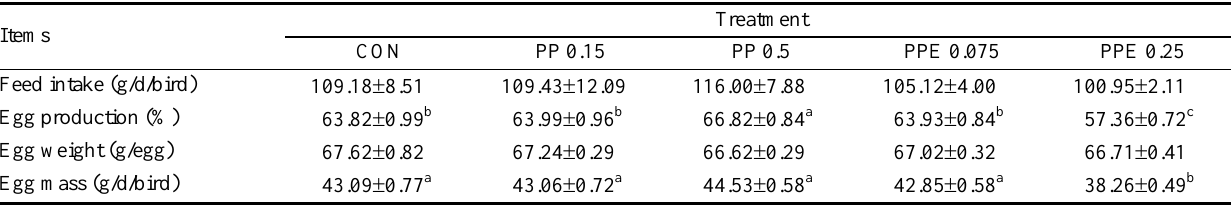
Table 2. Effects of persimmon peel (PP) and persimmon peel ethanol extract (PPE) on feed intake and production performance in laying hens 1